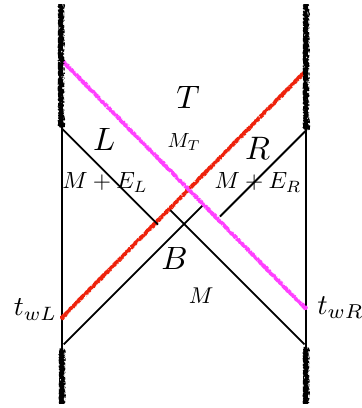
Figure 13 . Geometry with two neutral shockwaves